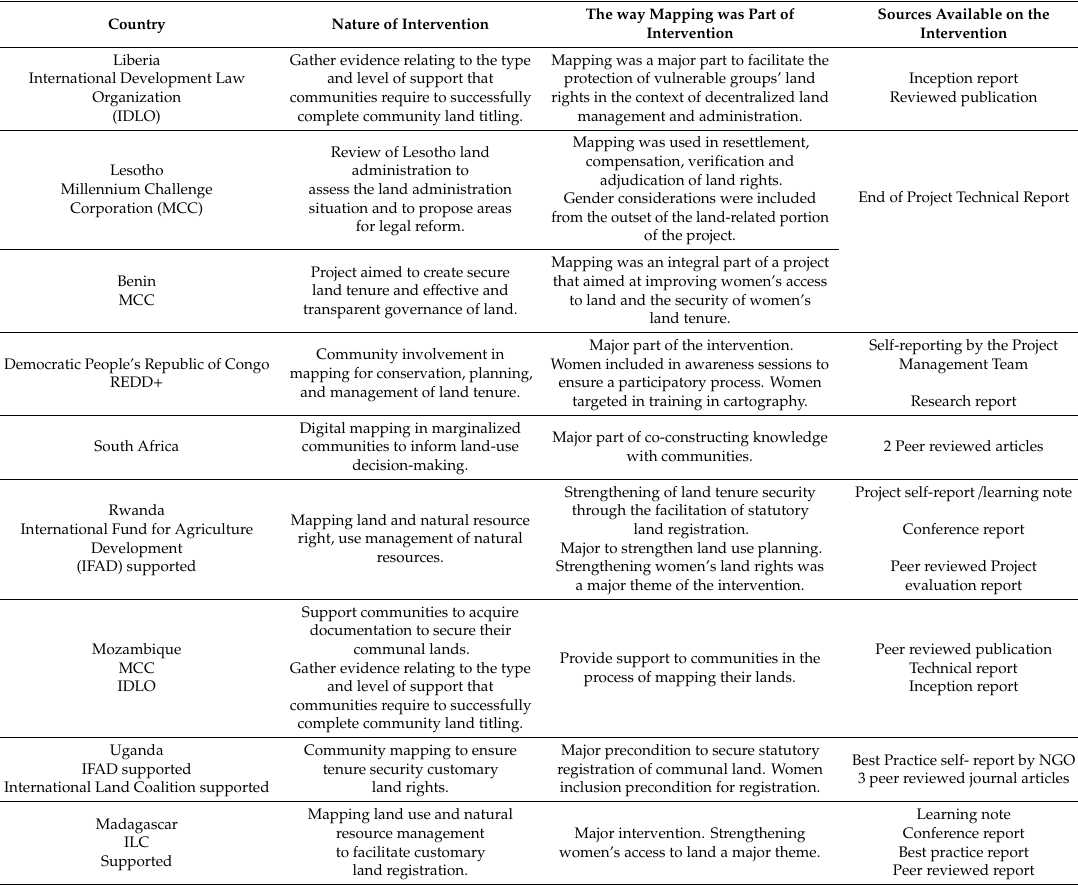
Table 1. Case study